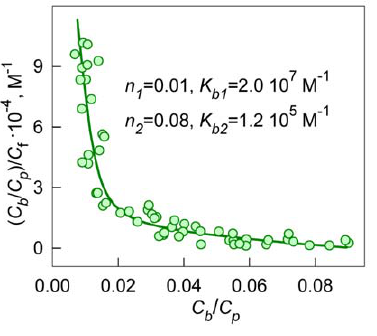
Figure2. Scatchardplots forThT interaction withinsulinamyloid fibril. Experimental data (circles) and best fit curve with binding constants ( K bi ) and number of binding sites ( n i ) given on the panels.